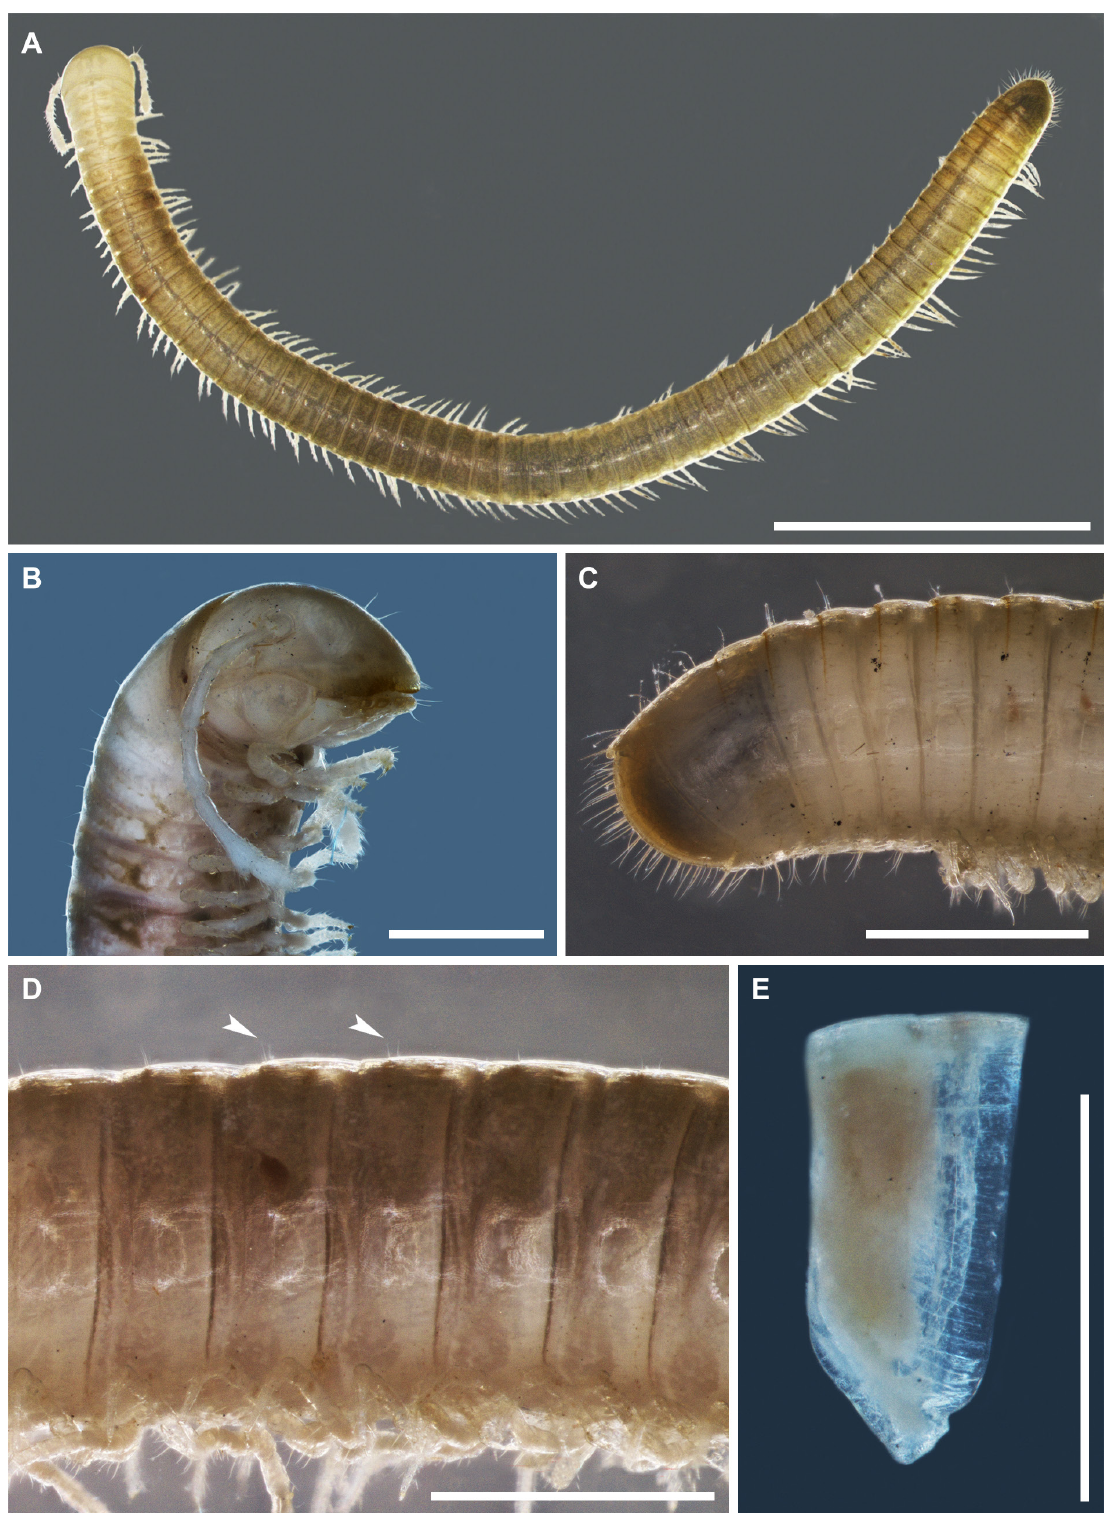
Fig. 19. Leucogeorgia gioi sp. nov., types from Sachinkia Cave (IZISU). A . Holotype ♂, habitus, dorsal view. B . Paratype ♀, anterior part of body, lateral view. C . Holotype, posterior part of body, lateral view. D . Paratype ♂, midbody rings, lateral view. E . Paratype ♂, body ring 7, lateral view. Arrows indicate metazonal setae. Scale bars: A = 5 mm; B–E = 1